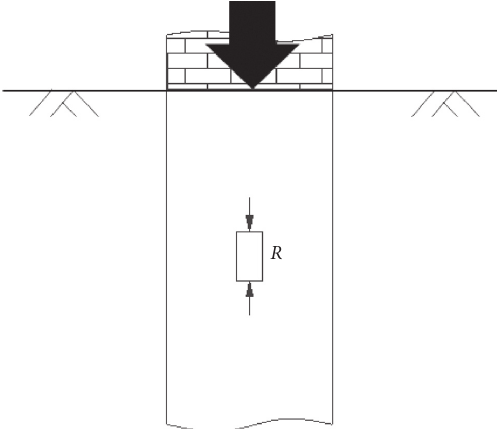
Figure 3: A single stress column.